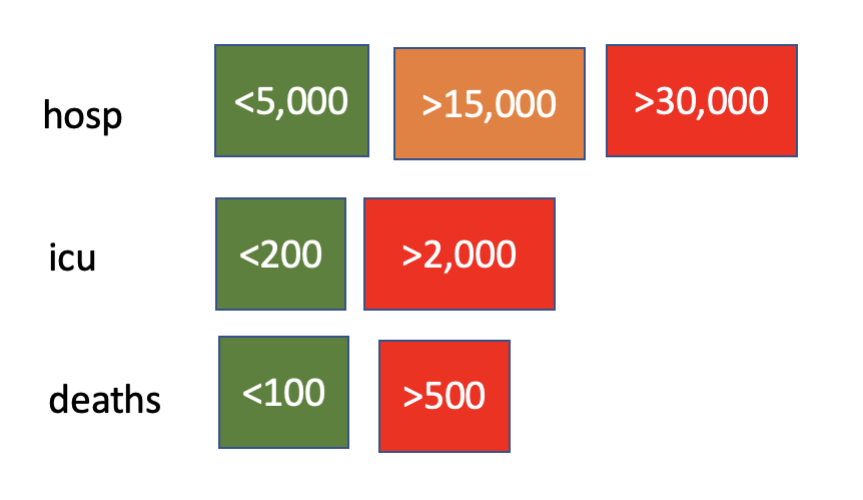
Figure 6. Cut-off points for health